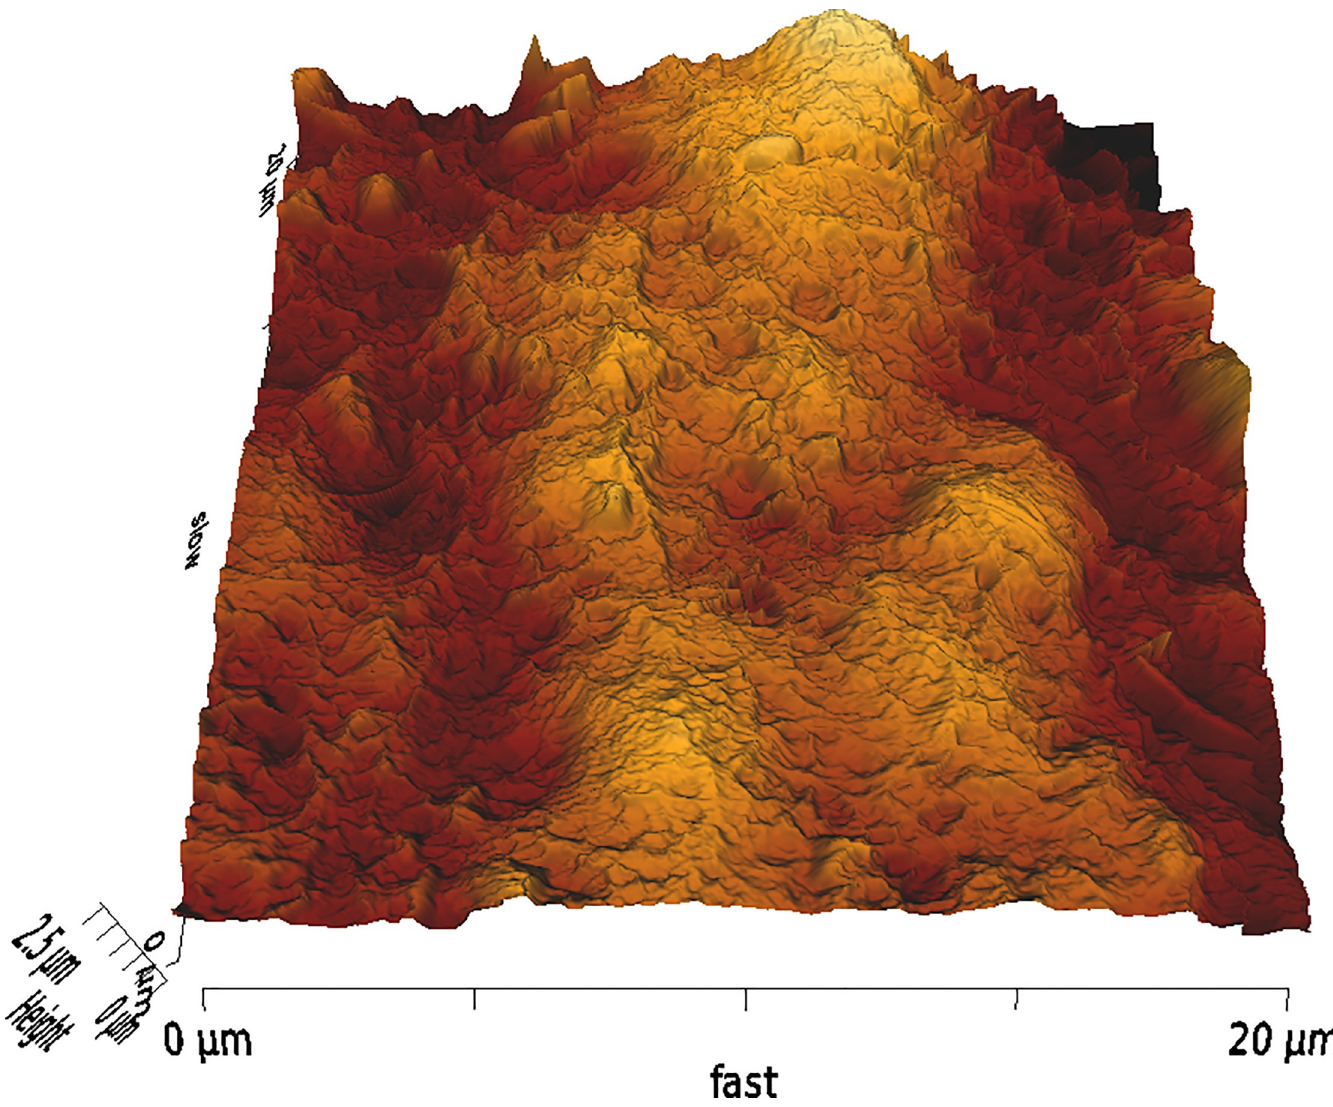
Fig 2. Example image of corneal surface treated with FS1 with 3D AFM